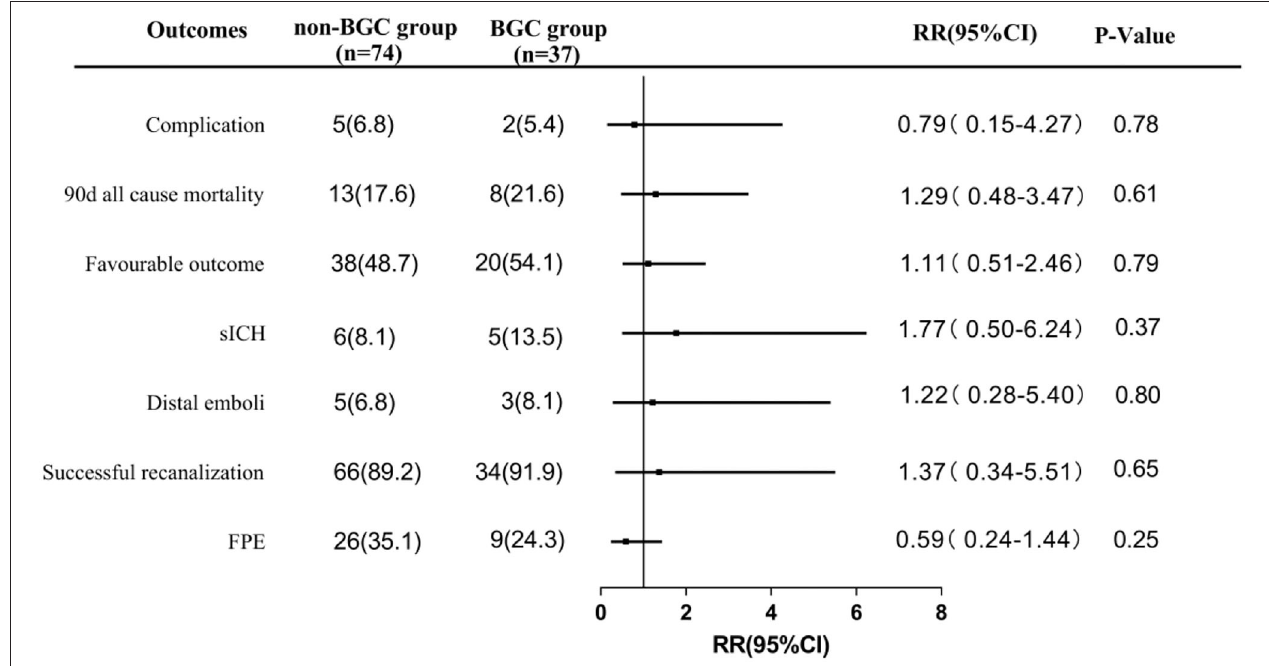
FIGURE 2 | Comparisons in angiographic and clinical outcomes in propensity-score-matched cohort. FPE, first pass effect; sICH, symptomatic intracranial hemorrhage; favorable outcome was defined as 90-day mRs 0 to 2. Complication was defined as vessel perforation, dissection or spasm; RR, relative